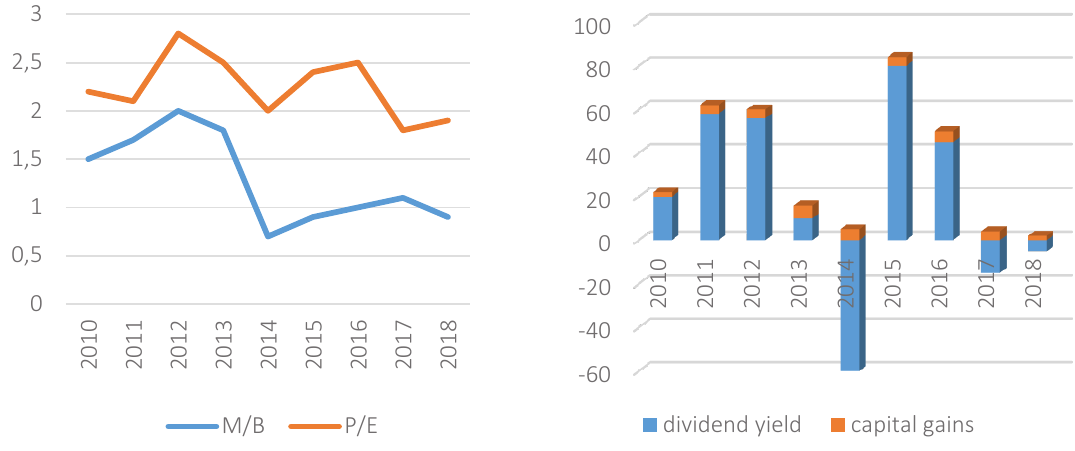
Figure 3. The average of the sample values of the value multipliers and shareholder